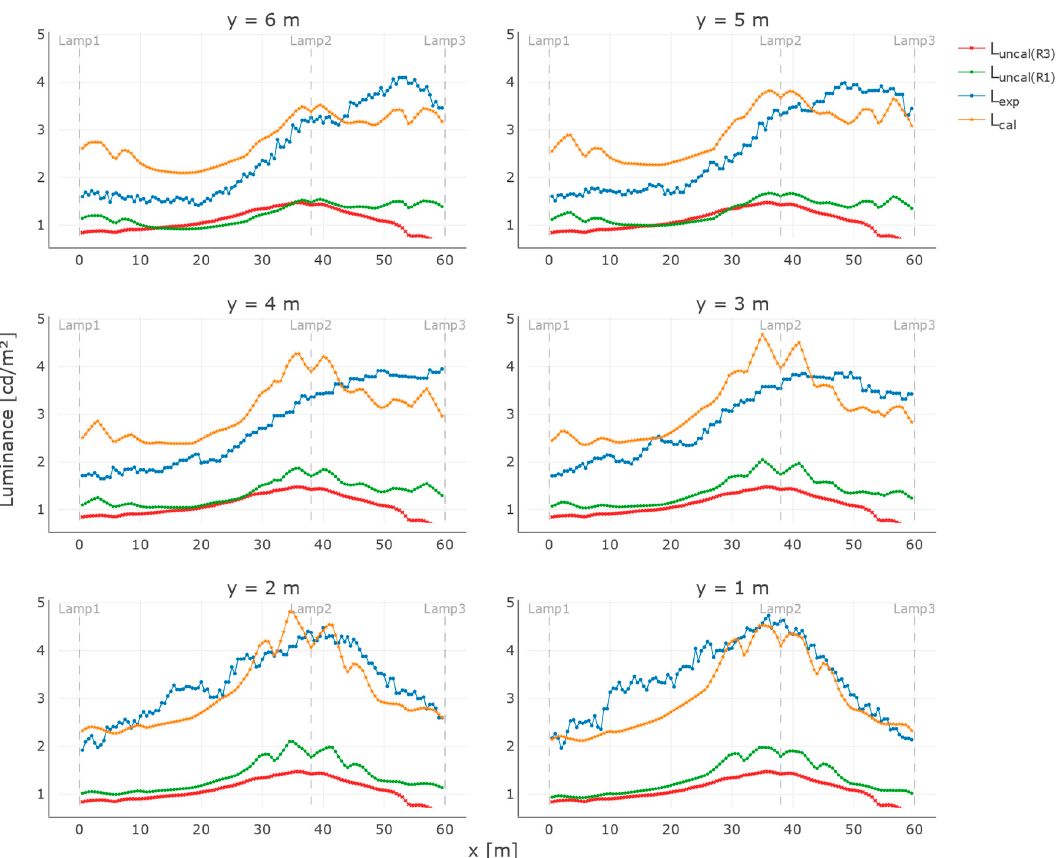
Figure 10. Luminance in longitudinal sections of the road. L exp : luminance collected experimentally; L uncal ( R 1 ) : simulated luminance using the lightness established by default for a R1 road surface; L uncal ( R 3 ) : simulated luminance using the lightness established by default for a R3 road surface; and L cal : simulated luminance after the calibration of the Q 0 factor.